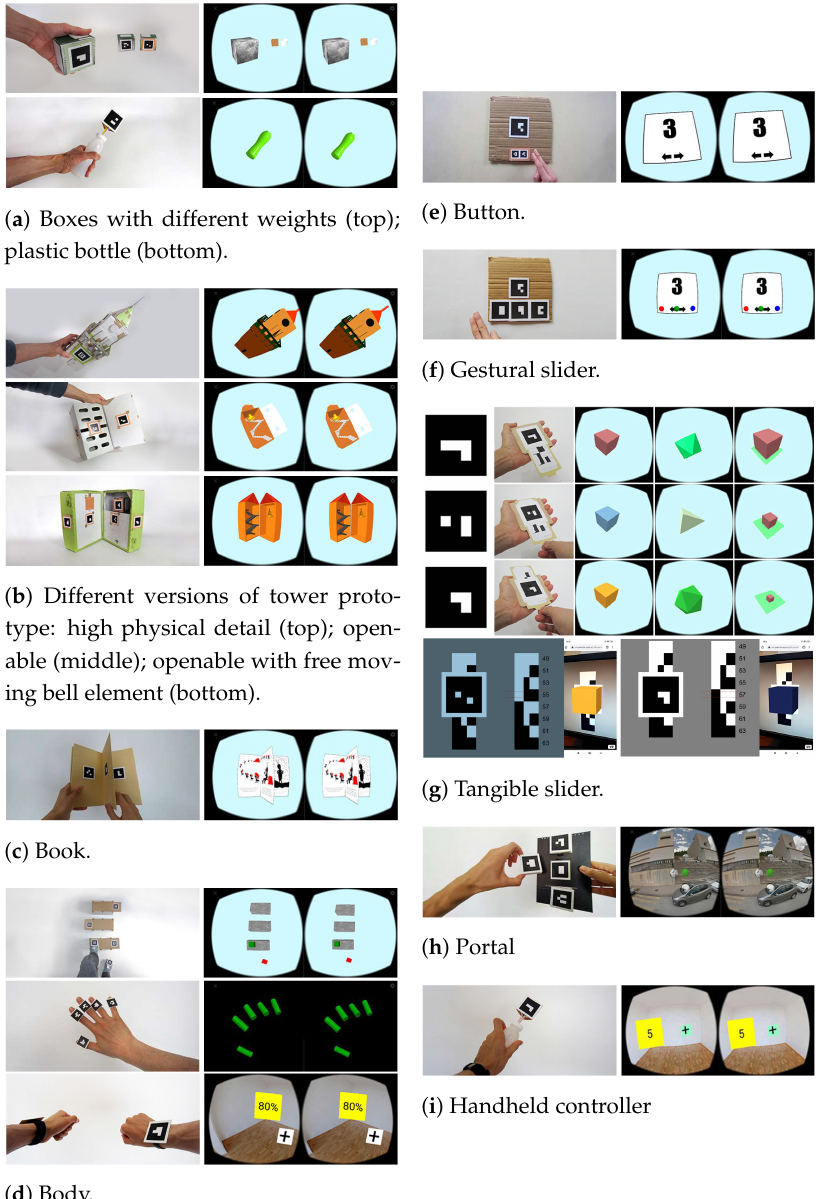
Figure 1. Selection of early marker-based TUI for VR